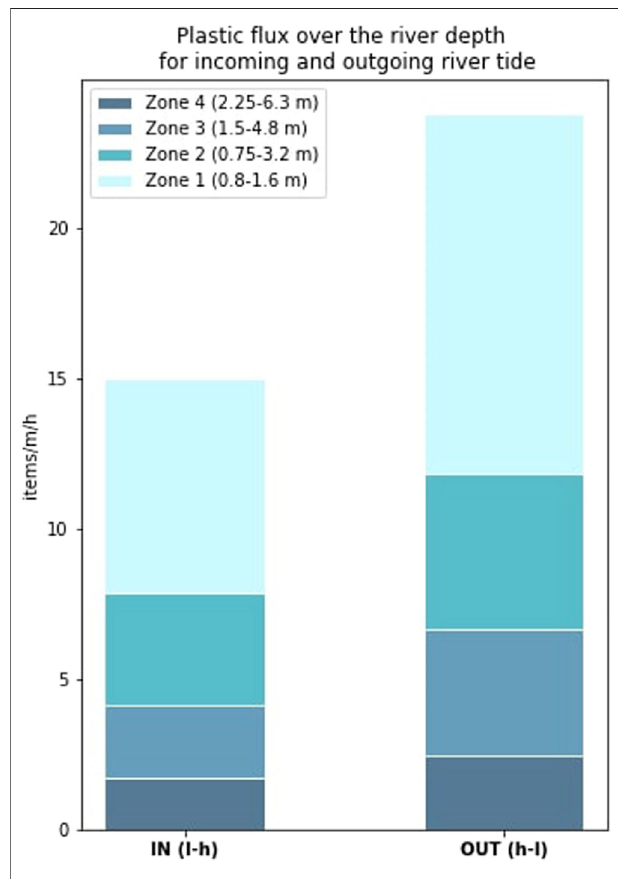
FIGURE 9 | Monitored litter (items/hour/m river width) distribution over the river depth (divided in four zones) for incoming and outgoing river tide.